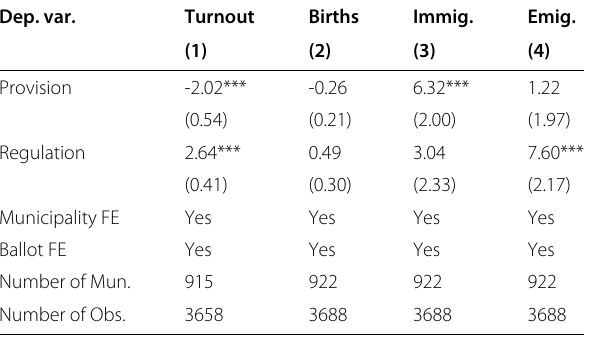
Table 9 DiD estimates of the introduction of lunchtime and after-school care on covariates Dep. var.